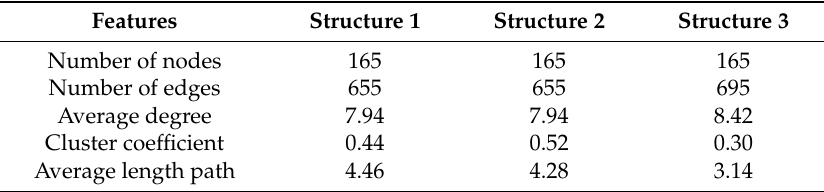
Table 4. Statistical features of three UAV swarming networks.